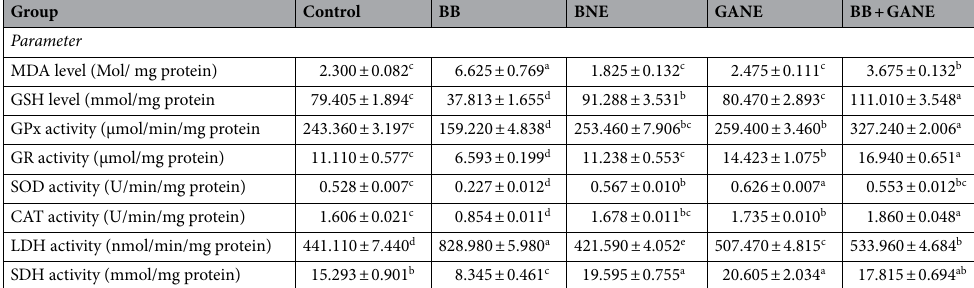
Table 1. Effects of gum Arabic nanoformulation on redox potential, and marker enzymes of mitochondrial respiration and glycolysis in the brain of adult male rats challenged by bromobenzene. GA gum Arabic; BB bromobenzene; BNE blank nanoemulsion: GANE gum Arabic loaded ananoemulsion; BB + GANE bromobenzene + gum Arabic loaded nanoemulsion. MDA malondialdehyde; GSH reduced glutathione; GPx glutathione peroxidase; GR glutathione reductase; SOD superoxide dismutase; CAT catalase; LDH lactate dehydrogenase; SDH succinate dehydrogenase. Results are expressed as the mean ± SEM of 5 rats per group. a–d Different letters indicate significant difference at p < 0.05 (one-way ANOVA followed by Duncan post-test).